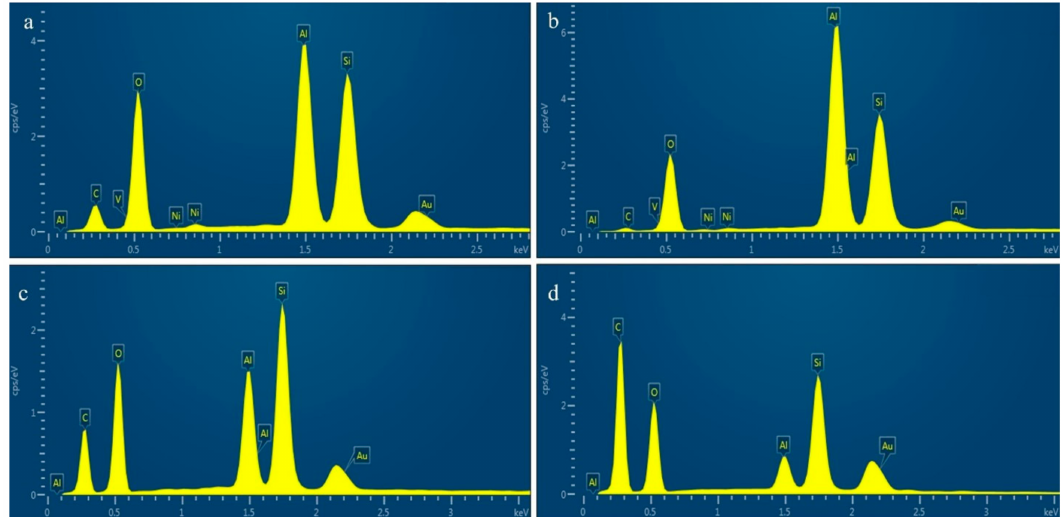
Figure 12. EDS images of the spent catalyst and various leaching residues: (( a ) SFCC catalysts; ( b ) leaching residue by C 2 H 2 O 4 ; ( c ) leaching residue by C 2 H 2 O 4 + H 2 O 2 ; ( d ) leaching residue by C 2 H 2 O 4 + H 2 O 2 with the microwave-assisted